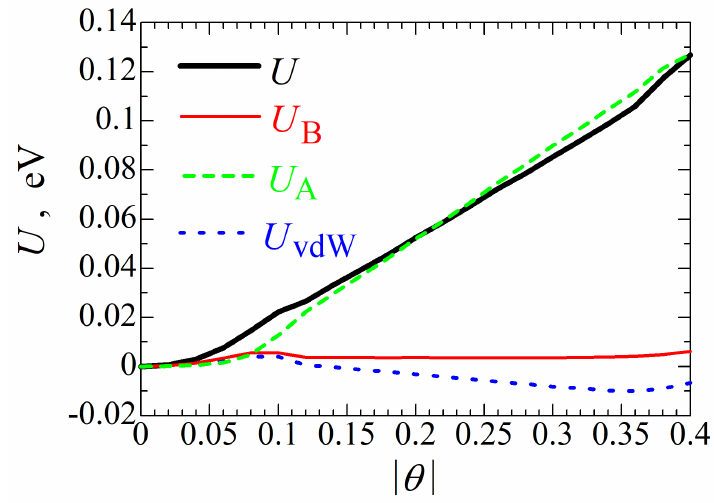
Figure 4. Potential energy of the relaxed CNT bandle and its three components as the functions of volumetric compressive strain. Total energy U is given by the thick black line, the energy of the valence bonds U B by the thin red line, the energy of valence angles U A by the green dashed line and the energy of van der Waals interactions U vdW by the blue dotted